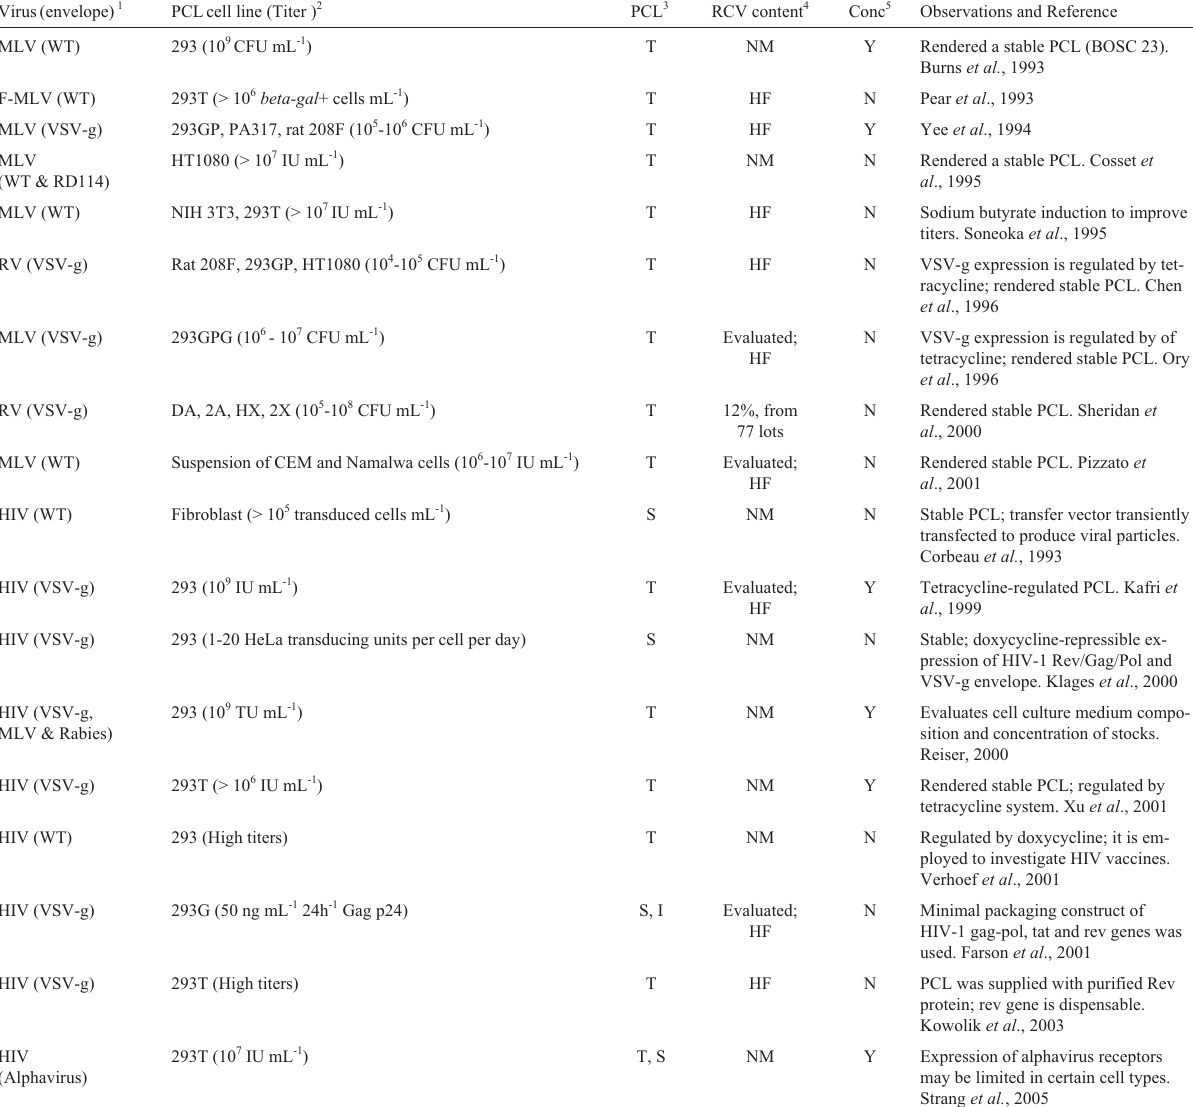
Table 1 - Characteristics of some of the protocols available for retrovector